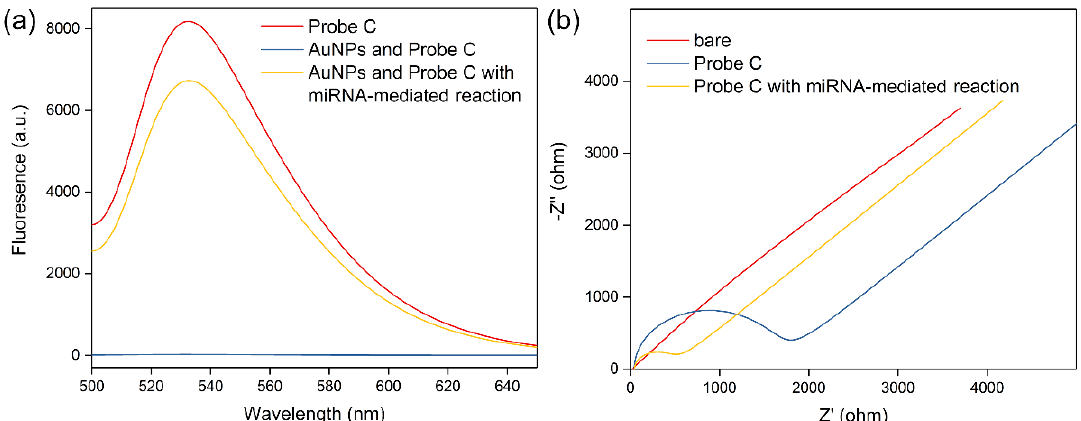
Figure 3. ( a ) Fluorescence emission spectra of Probe C, AuNPs and Probe C before and after miRNA- mediated structural switch. ( b ) Nyquist plots of the bare gold electrode and electrode modified with Probe C without and with structural switch.